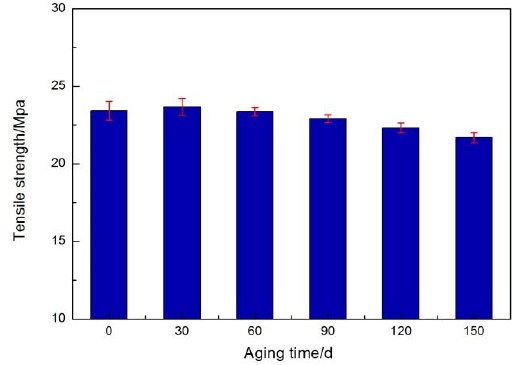
Figure 5. Tensile strength of polyurea coating.